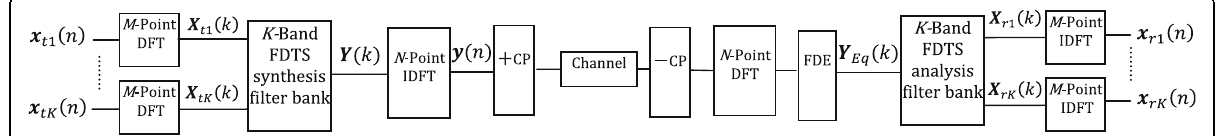
Fig. 7 GOFDM block diagram based on optimum low-complexity tree-structured PR-QMF bank